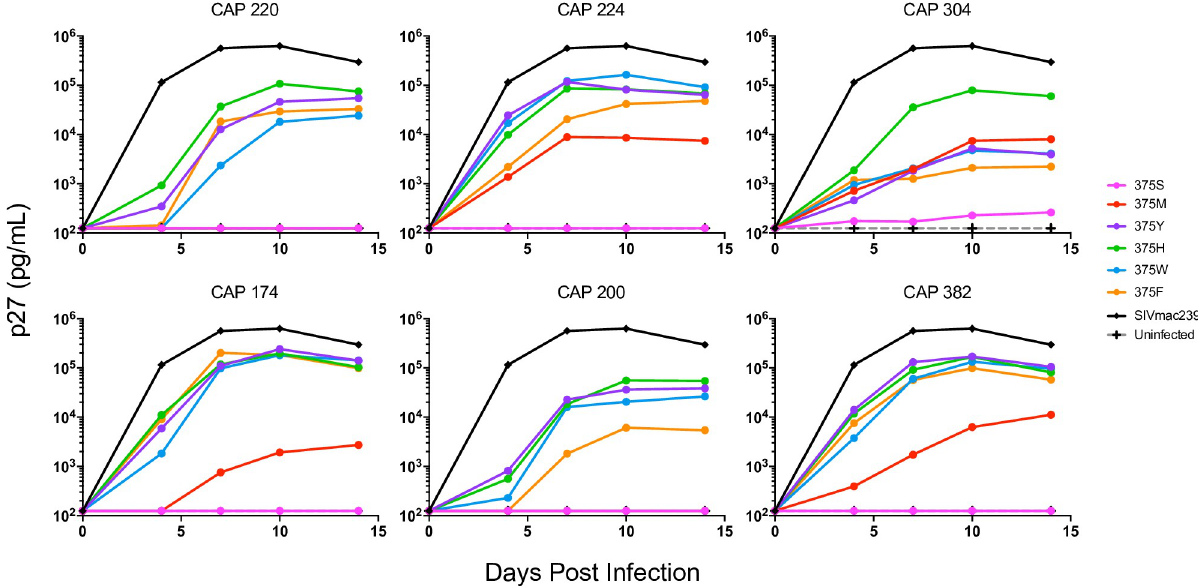
Fig 3. In vitro replication of SHIV 375 mutants. In vitro replication of each Env375 polymorphism was assessed by measuring p27 levels in activated primary rhesus CD4 + T cells over the course of 14 days. Individual SHIVs were used to infect 10 6 activated rhesus CD4 + T cells at a nominal MOI of 0.02. Culture supernatants were collected over 14 days, with media replacement at each collection time-point to maintain cultures in 2 mL total volume. Viral p27 protein was quantified by ELISA. Each polymorphism is represented by a different color.